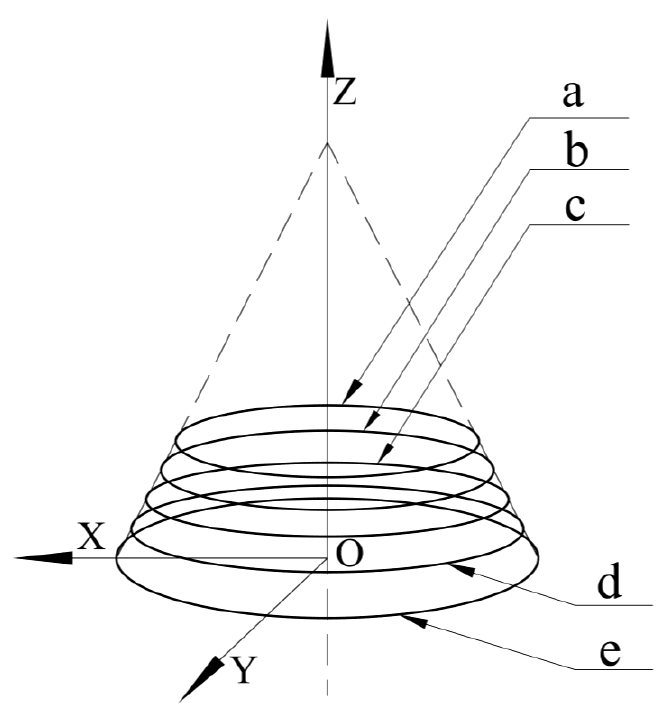
Figure 2. Detection circles used in the coaxial multi-ring measurement method.